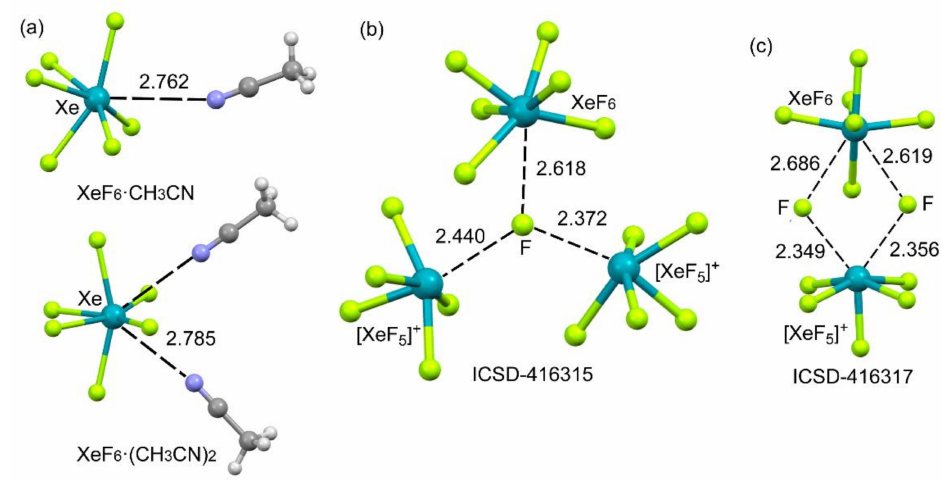
Figure 18. Partial views of the X-ray structures corresponding to XeF 6 · CH 3 CN adducts ( a ) and ICSD reference codes ICSD-416315 ( b , m C 32 phase) and ICSD-416317 ( c , m P 32 phase). Distances in